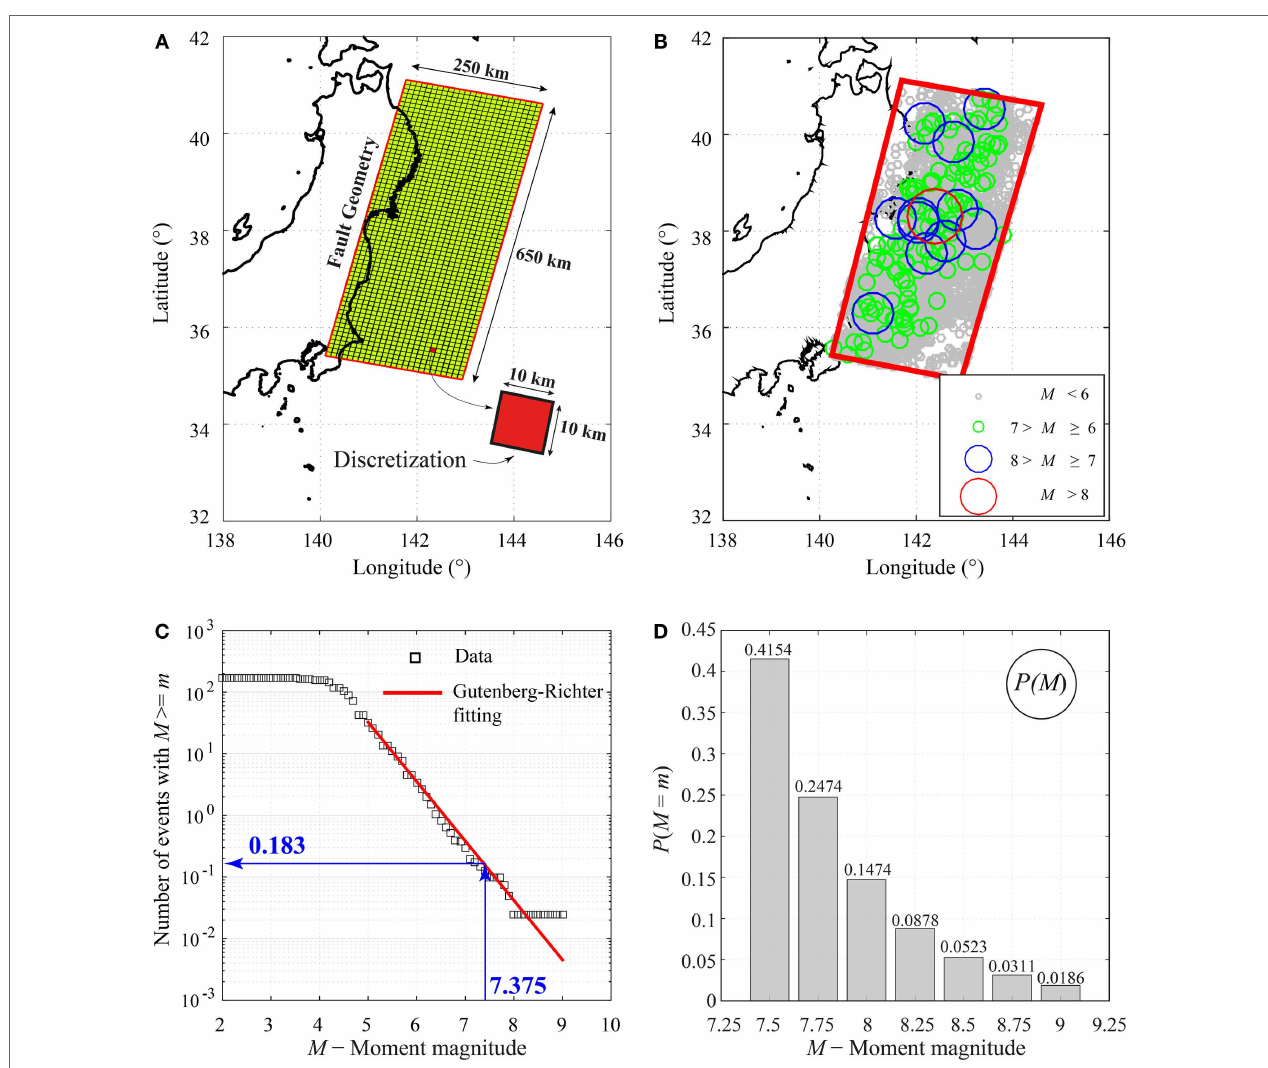
FIGURE 3 | (A) Fault plane model and discretization. (B) Spatial distribution of earthquakes in the source region using the NEIC catalog. (C) Gutenberg–Richter relationship. (D) Discrete probability mass based on the fitted Gutenberg–Richter